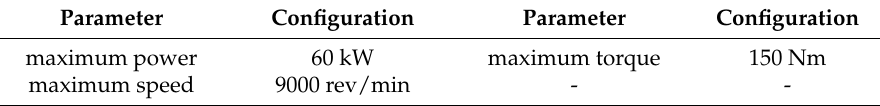
Figure 7. External characteristic of permanent magnet synchronous motor. Table 3. Configuration parameters of permanent magnet synchronous motor (PMSM).